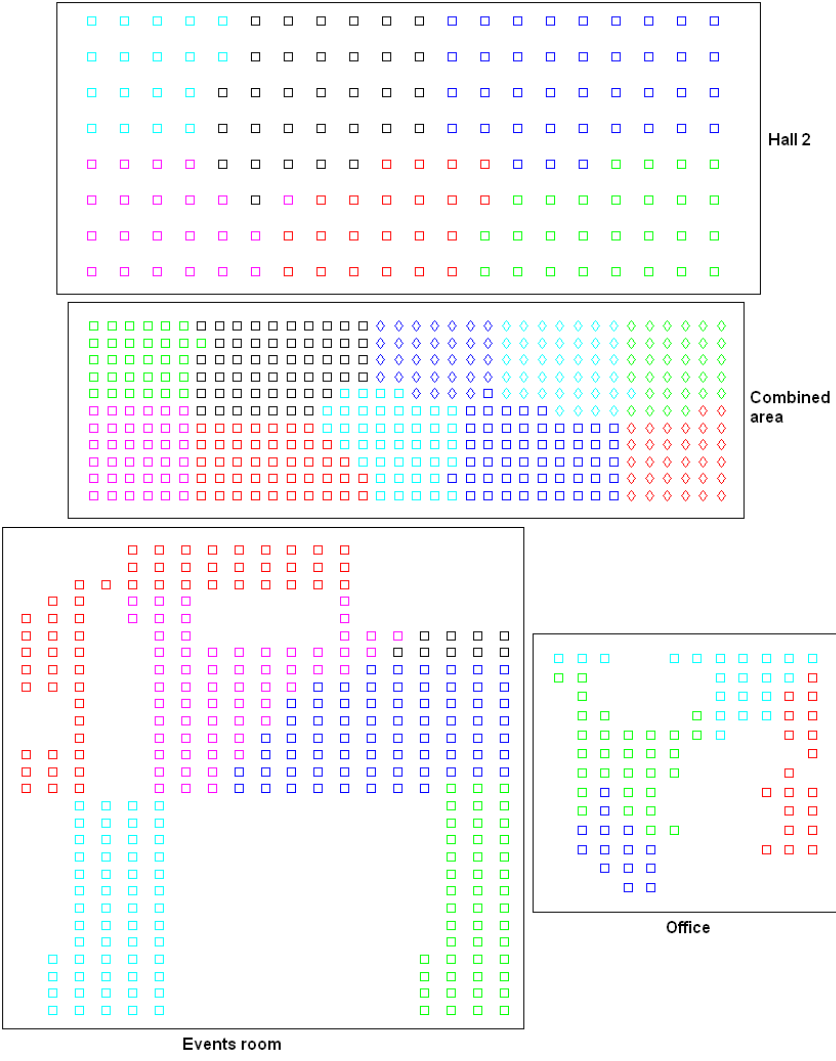
Figure 21. Results of the intermediate-level mapping using gist with m = 16 masks and k 6 = 4 horizontal blocks. Bird’s eye view of the four additional rooms considered to validate the approach. The colors of the capture points indicate the cluster they belong